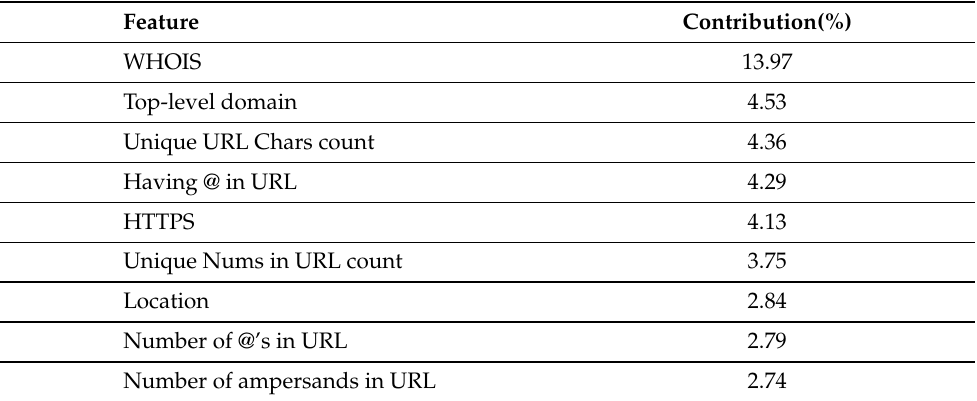
Table 5. Top 10 Contributing Features (without embeddings).